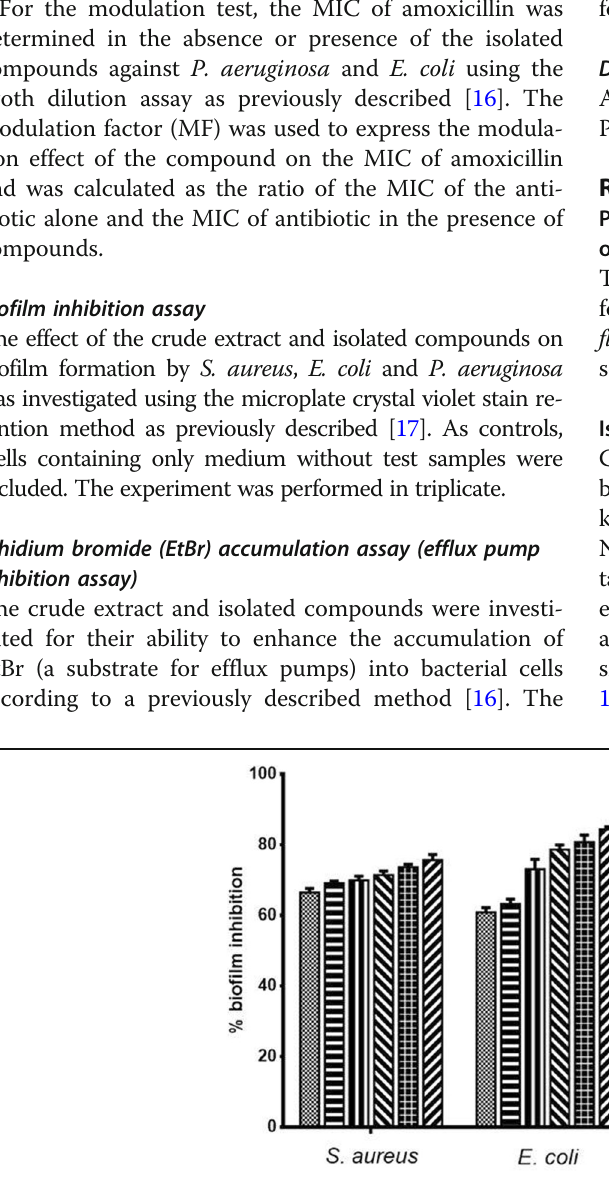
Fig. 2 Anti-biofilm formation effect of AG in S. aureus, E. coli and P.